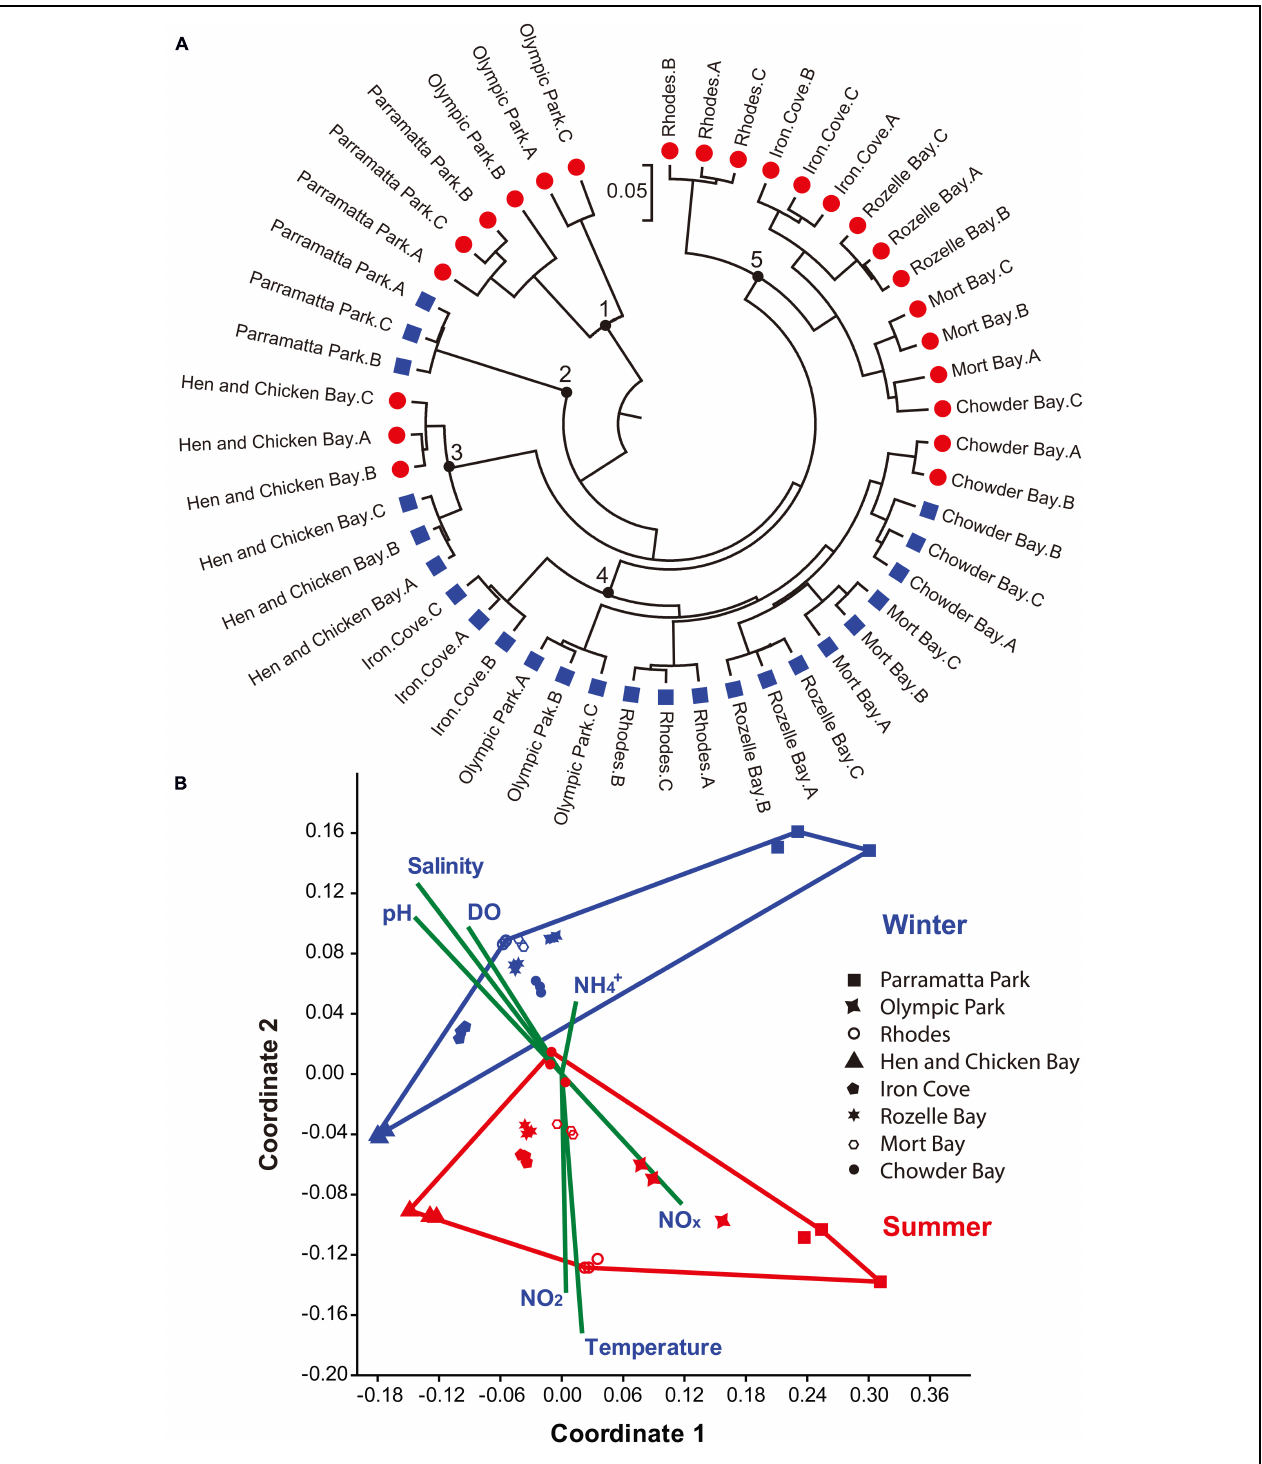
FIGURE 4 | Sample assessment using 16S rRNA gene sequences and environmental parameters. (A) Jackknife Comparison on the weighted sequence data was carried out using QIIME (Caporaso et al., 2010) and constructed with MEGA 6.0 (Tamura et al., 2013). Red circles denote summer (March) and Blue squares denote winter (June) samples. The bar represents five substitutions per 100 nucleotide positions. Black circles numbered 1–5 highlight different groups of sequences. (B) Non-metric MDS plot of the top 50 OTUs. Red and Blue points represent summer and winter samples, respectively. A, B, and C represent the three biological replicates. Shepard plot stress value was 0.1237. Vectors indicate the contribution of each environmental parameter using PAST (Hammer et al., 2001).